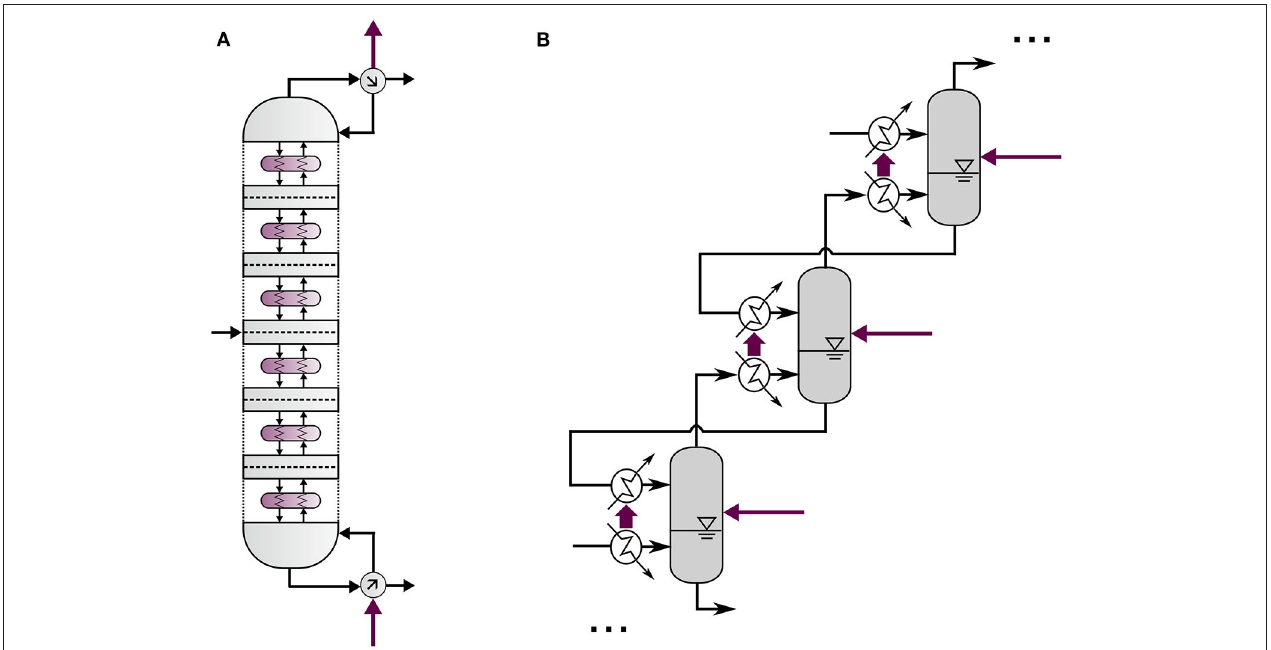
FIGURE 9 | Schematic illustration of a column with intermediate heat exchangers (A) , and corresponding interpretation as a series of heat integrated flash drums (B) .